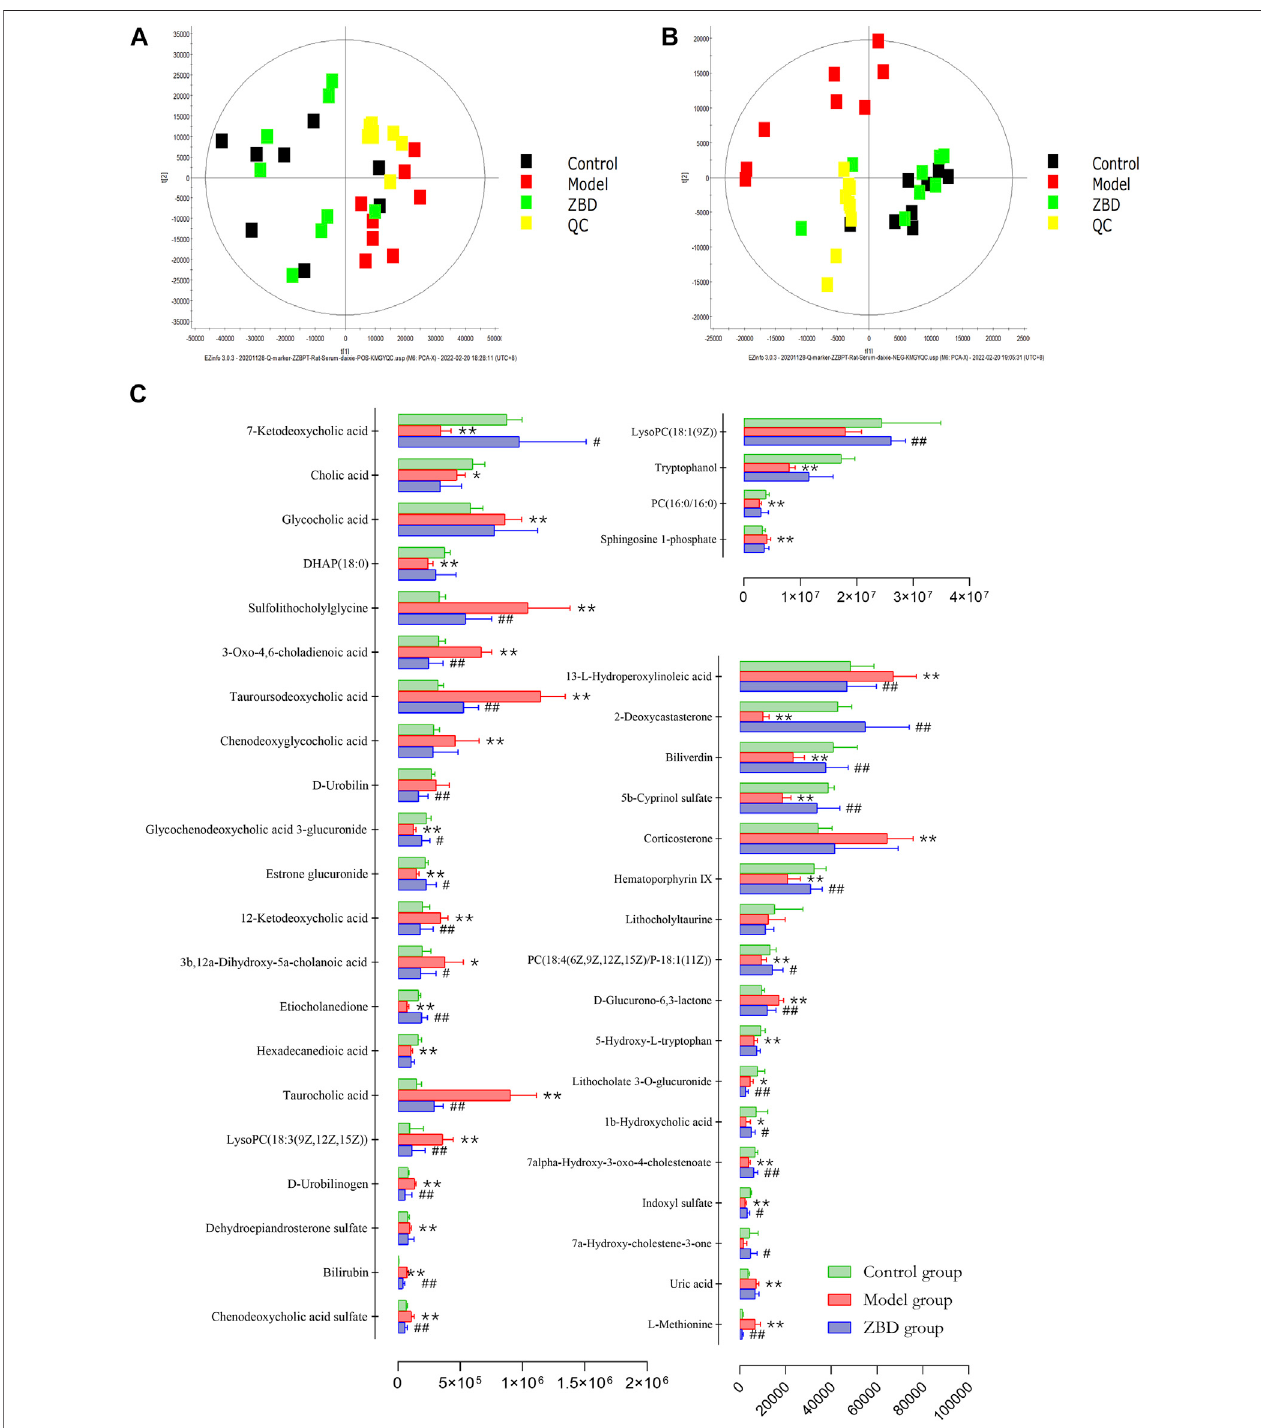
FIGURE 5 | Protective effects of ZBD as determined by metabolic analysis. (A) PCA score plots in positive mode. (B) PCA score plots in negative mode. (C) The relative intensity of serum metabolites associated with ZBD treatment of DHJS. * p < 0.05 and ** p < 0.01 model group compared with the control group; # p < 0.05 and ## p < 0.01 ZBD group compared with the model